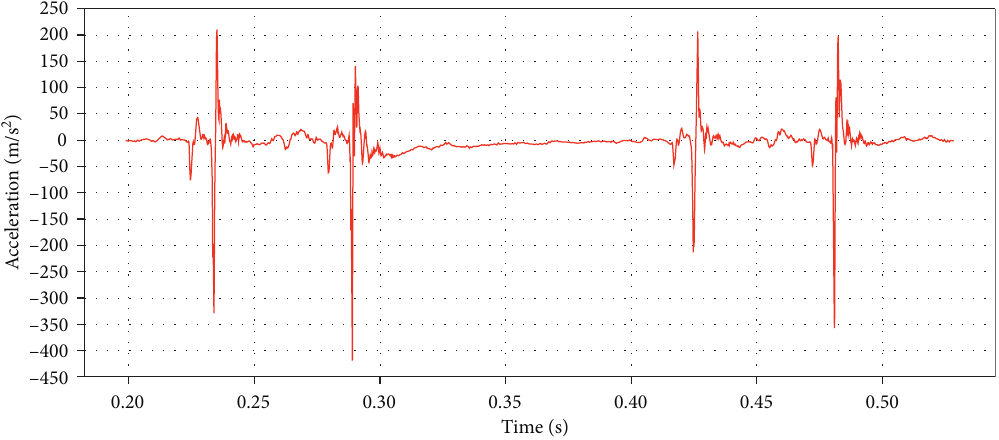
Figure 3: Detail of the locomotive part of the signal shown in Figure 2.